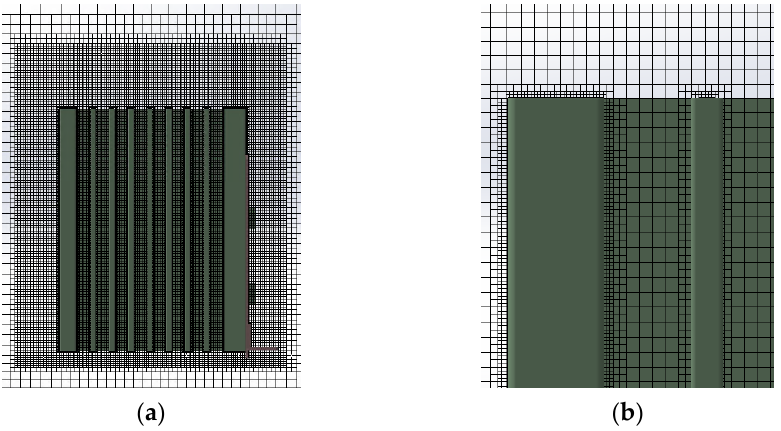
Figure 12. ( a ) Global mesh on plane plot; ( b ) Mesh detail in heatsink fins proximity.